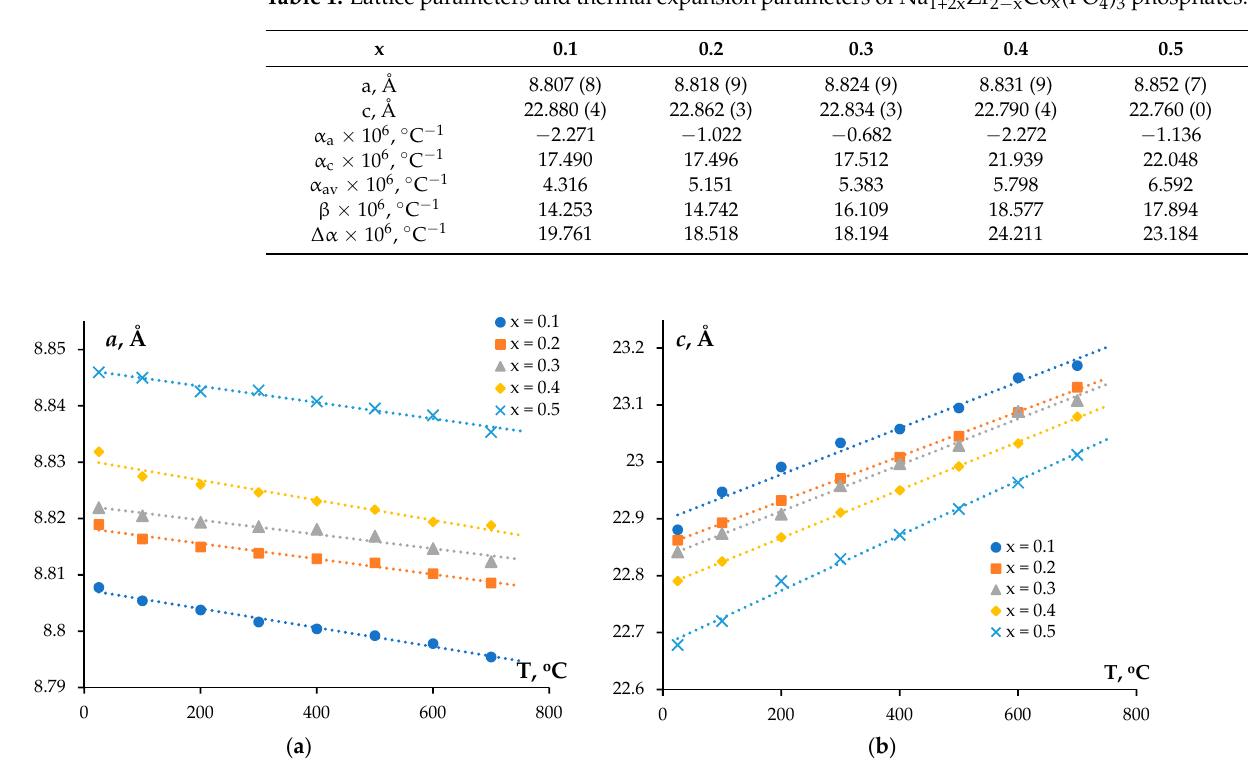
Figure 4. Dependences of crystal lattice parameters a and c on the composition of compounds Na 1+2x Zr 2 − x Co x (PO 4 ) 3 . Analysis of the results is presented in Figure 3. Table 1. Lattice parameters and thermal expansion parameters of Na 1+2x Zr 2 − x Co x (PO 4 ) 3 phosphates.